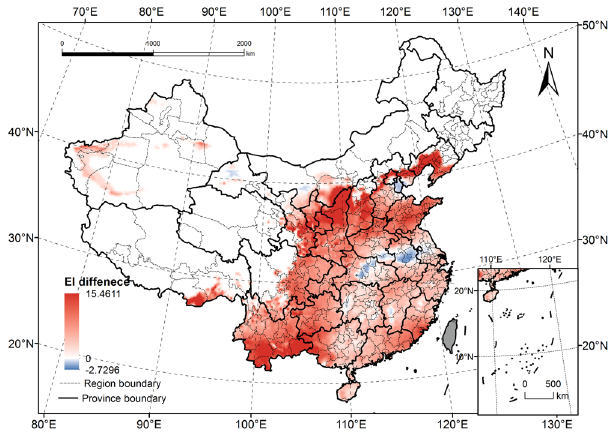
Figure 7. Change of the EI values under current (1981–2010) and future (2011–2040) conditions in China. Red means increase, blue means decrease, the deep of the color show the change degree of EI values. The CLIMEX results were exported into GIS software (ArcGIS for Desktop, Software Version 10.2, http://resources.arcgis. com/en/home/) to generate the map in this figure.